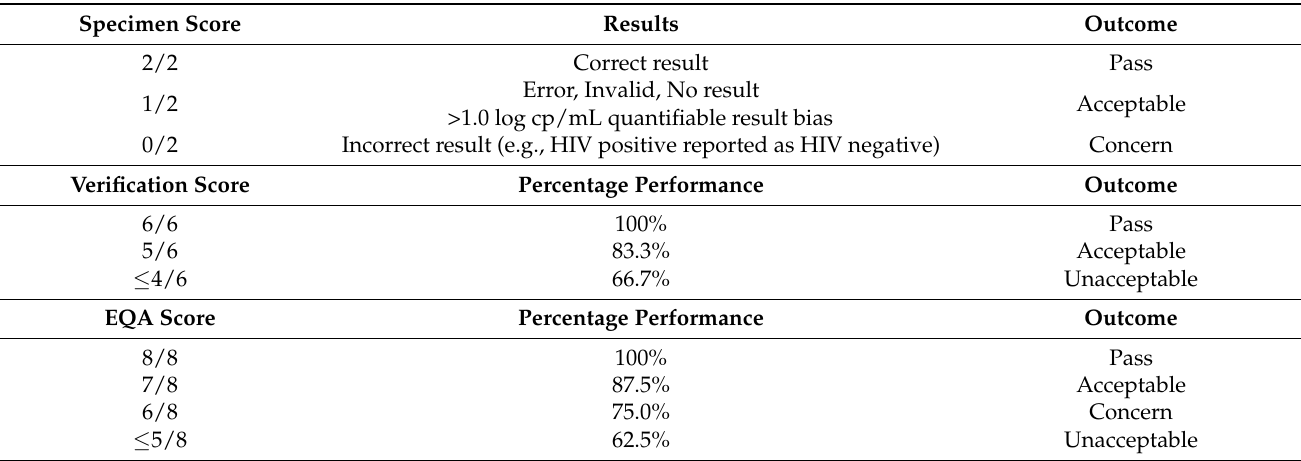
The table is divided into specimen score, verification score and EQA score sections (shown in bold). Specimen Score: Each specimen generates a score out of two. Verification Score: Verification of a module generates a score out of six (three specimens per module). EQA Score: EQA of an instrument generates a score out of eight (four specimens per instrument, run over different modules). If an unacceptable score is obtained, the site is required to conduct a root cause analysis and corrective action, and to test a second verification